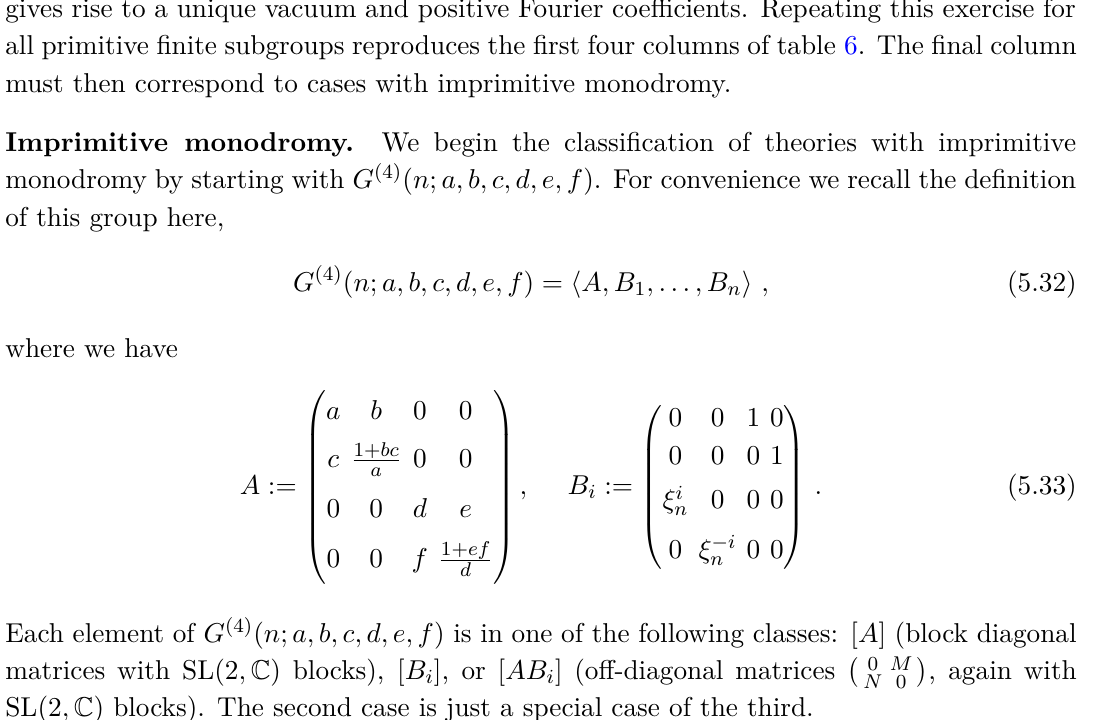
Table 11 . The character table of a primitive finite subgroup G (4) √ (1 ± 5) 1 2